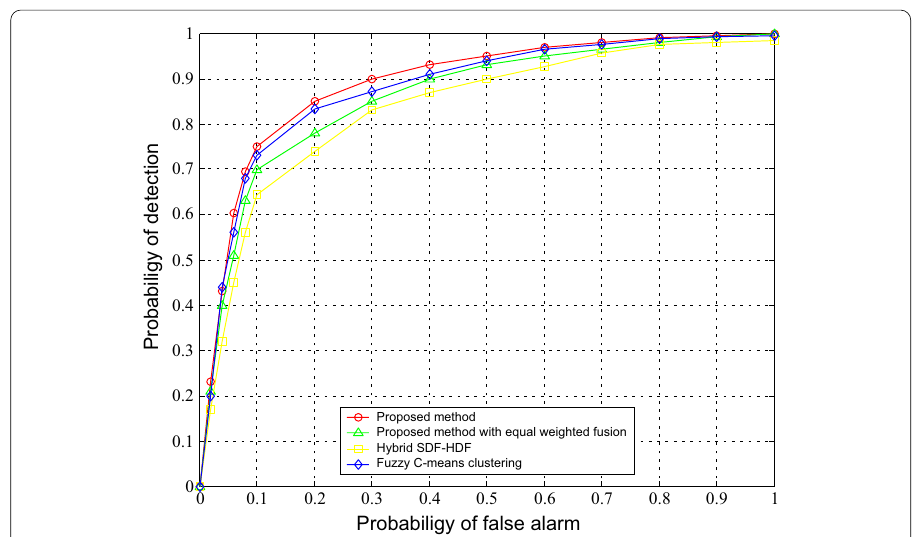
Fig. 1 Comparison of detection probability under different probability of false alarm ( N